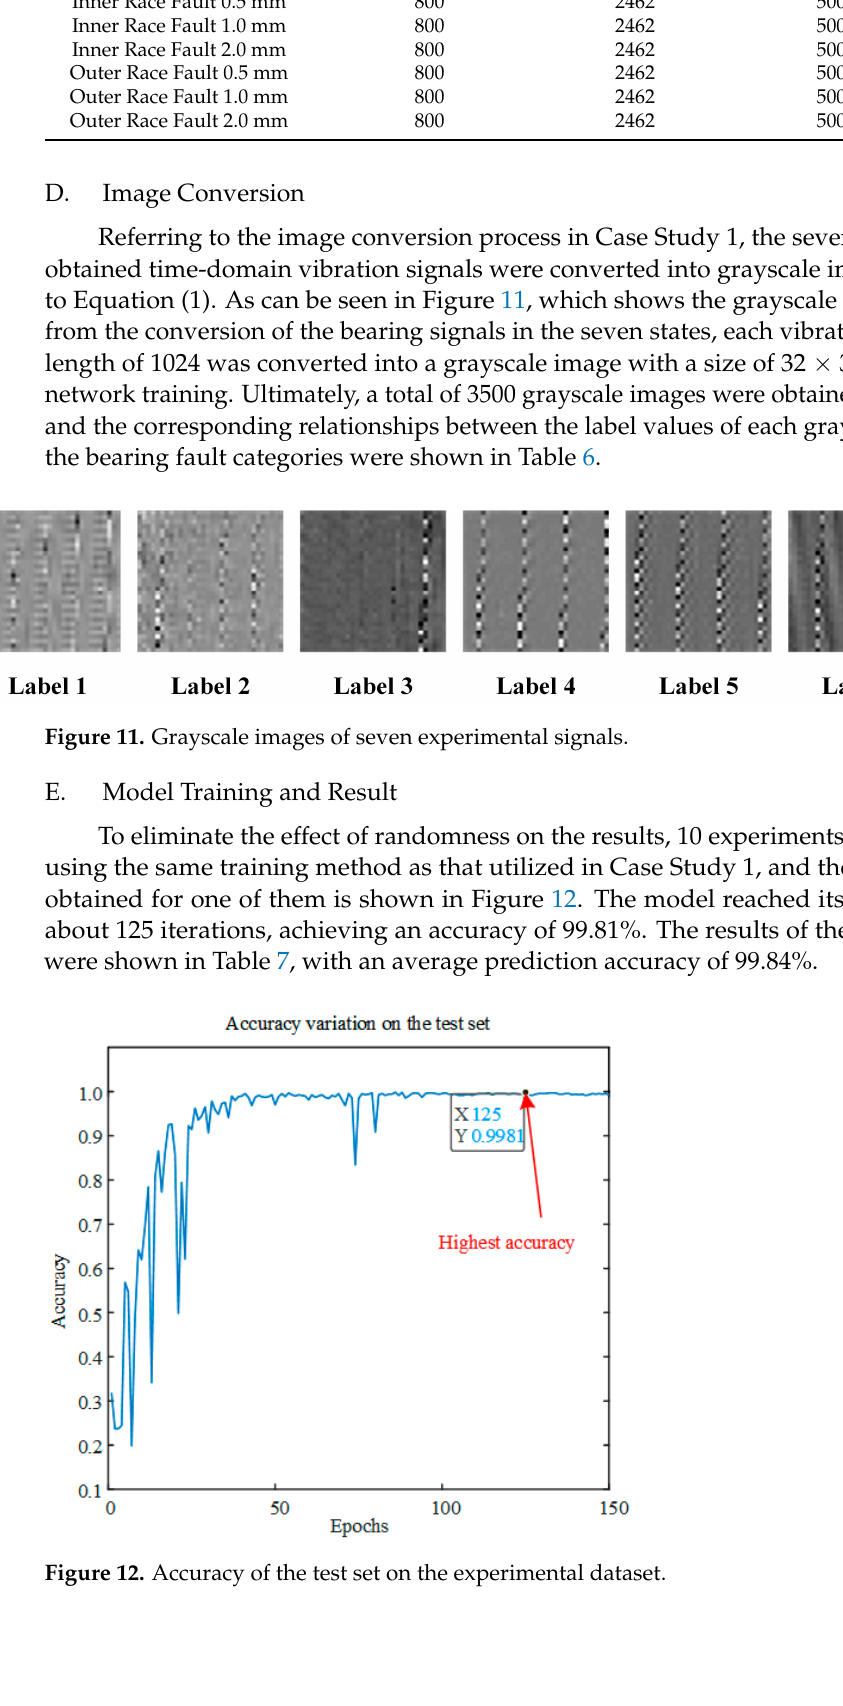
Figure 12. Accuracy of the test set on the experimental dataset.